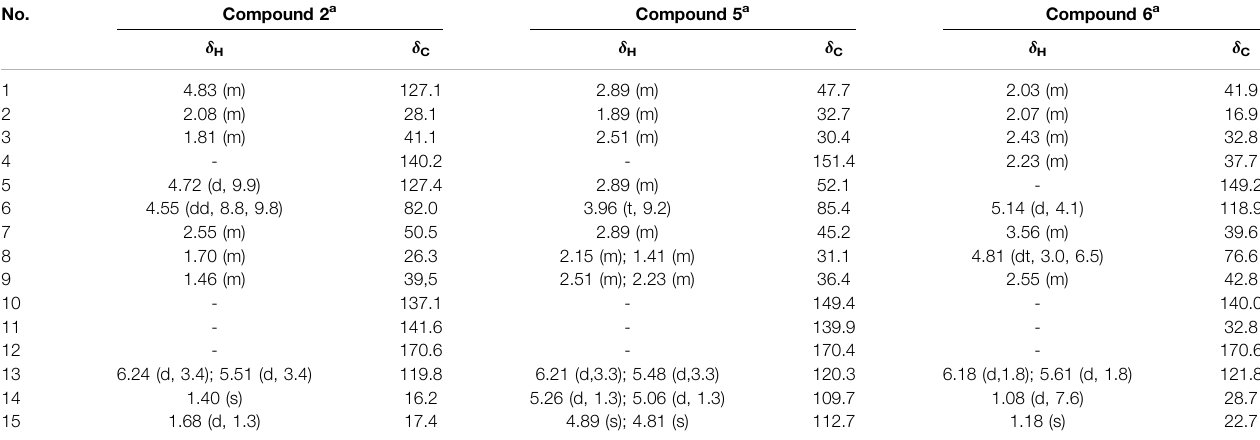
TABLE 6 | 1 H and 13 C-NMR data of Compound 2, Compound 5 and Compound 6 (CDCl 3 , δ in ppm, J in Hz). No.